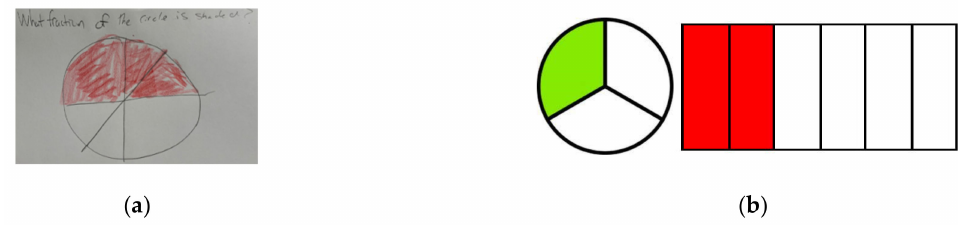
Figure 3. ( a ) Example 1. ( b ) Example